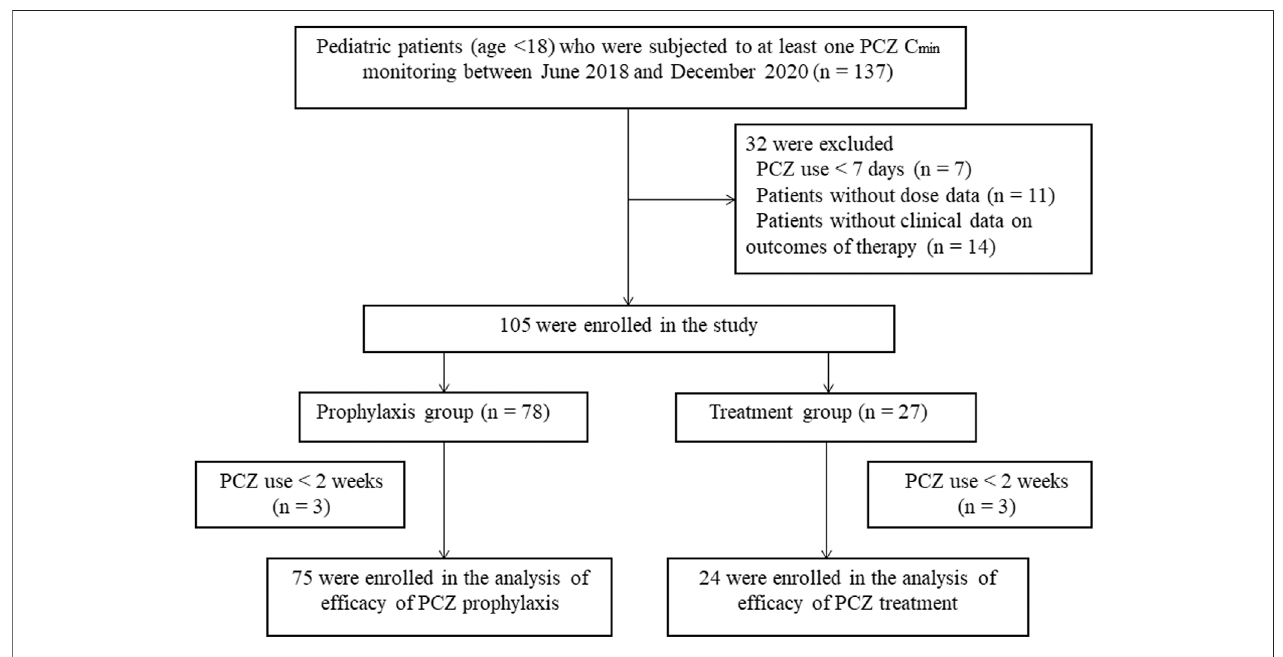
FIGURE 1 | Flow chart of the study.